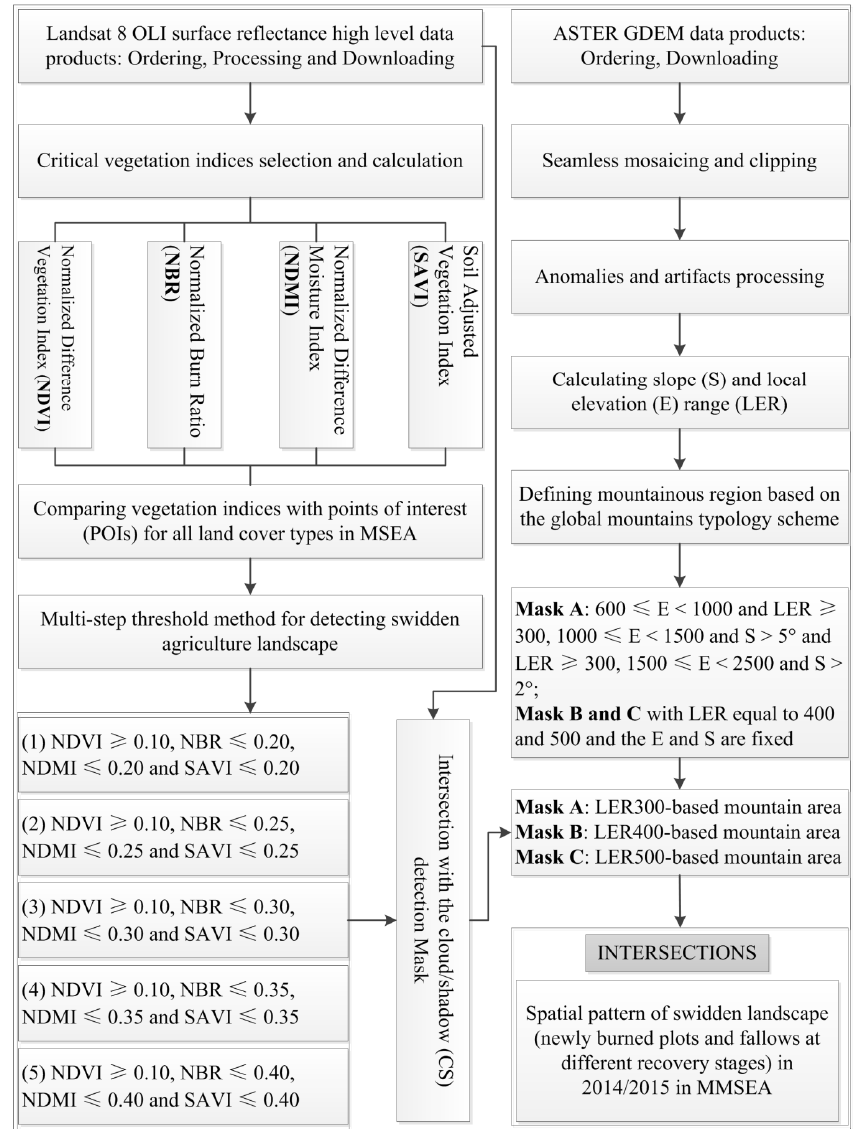
Figure 5. The flowchart of swidden landscape delineation procedures with the multi-step threshold (MST) method using Landsat OLI imagery in MSEA.